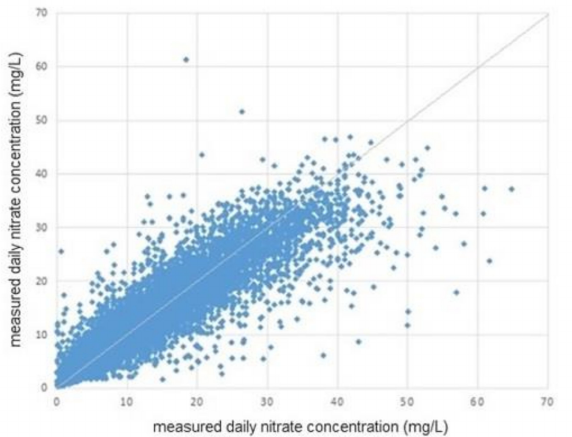
Figure 3. Measured versus predicted flow-weighted daily concentrations using the WRTDS methodology considering all stations together for the period